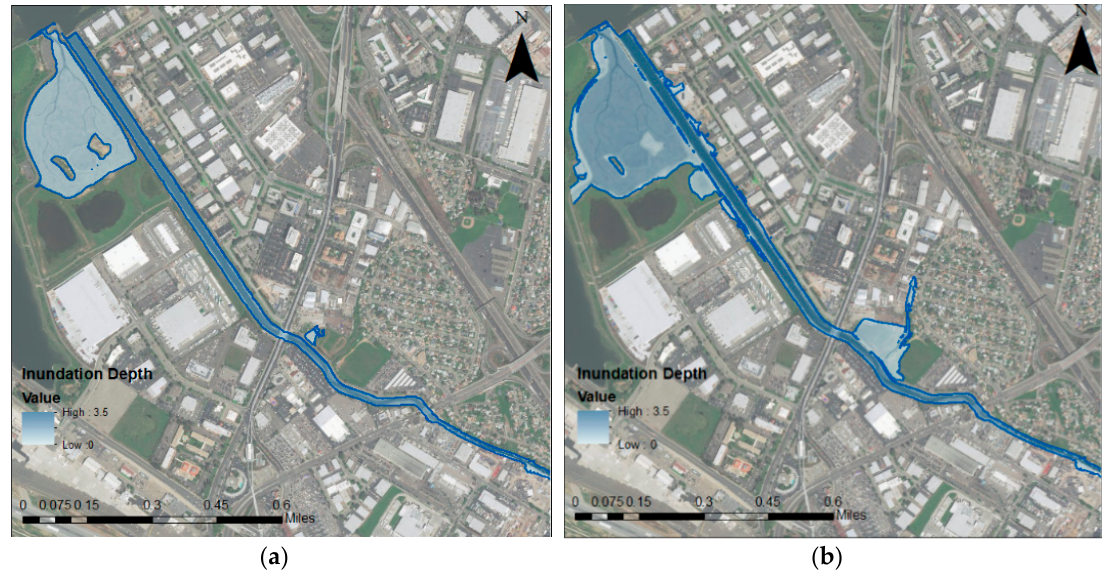
Figure 7. ( a ) Blue area shows compound impacts of high tide (1.94 m) and 2 year precipitation, ( b ) shows compound impacts of high tide, 1 m SLR, and a 2-year